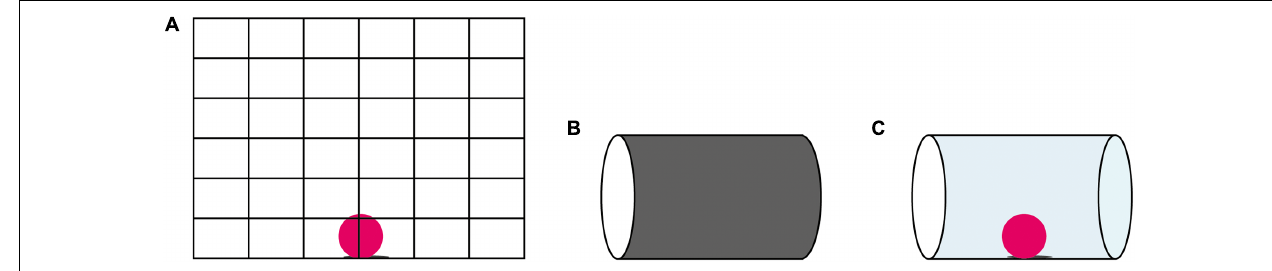
FIGURE 1 | The materials for the detour tasks: (A) the mesh barrier; (B) the opaque cylinder; (C) the transparent cylinder.